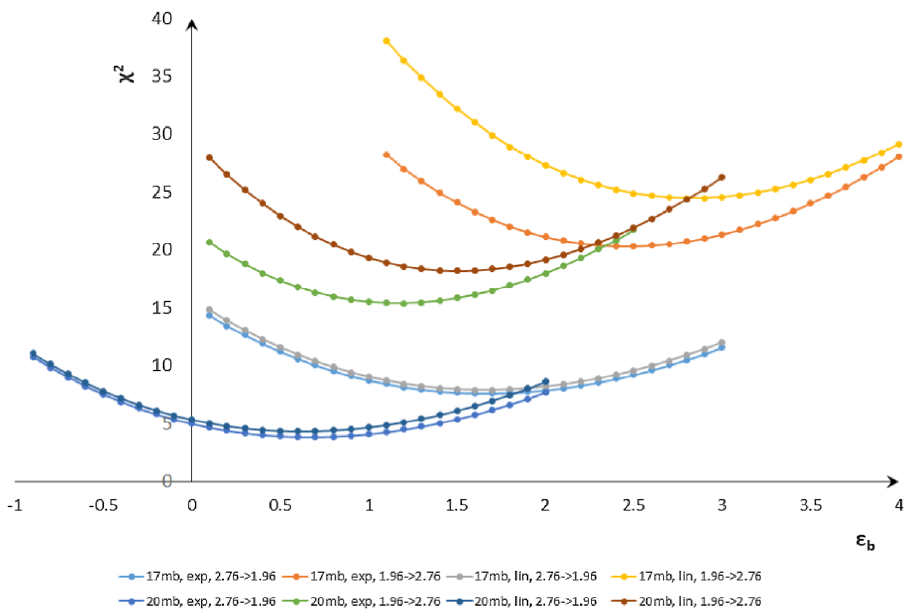
Fig. 11 Dependence of χ 2 on the coefficient of the correlated but the choice of linear-linear or linear-exponential interpolations in H ( x ) , point-to-point varying systematic errors, (cid:13) b , for the comparison of the to a different choice of the elastic cross section of p ¯ p collisions at √ √ H ( x ) scaling functions of elastic p ¯ p collisions at s = 1 . 96 TeV, mea- s = 1 . 96 TeV (20 . 2 ± 1 . 4 mb vs 17 . 6 ± 1 . 1 mb), and to the direction sured by the D0 experiment at Tevatron [8], with that of elastic pp of the projection (1 . 96 → 2 . 76 TeV, or 2.76 TeV → 1.96 TeV). A clear √ s = 2 . 76 TeV, measured by the TOTEM experiment at collisions at parabolic structure is seen in each case and the fit quality of the results that belong to these minima in (cid:13) b is summarized in Table 3 the LHC [4]. All the eight cases are shown together corresponding to